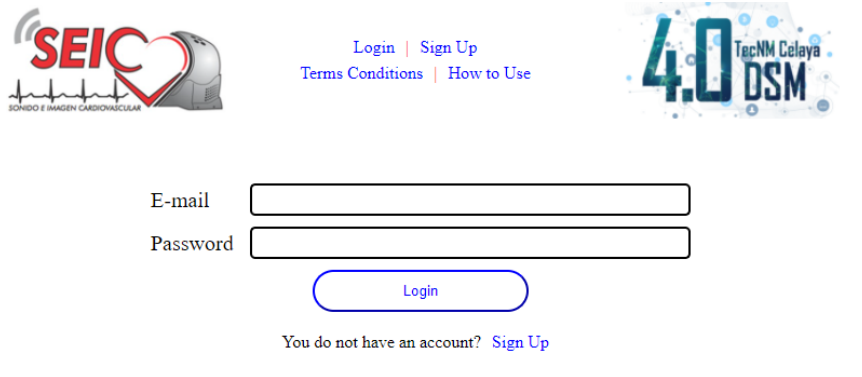
Figure 9. Registered user login form.